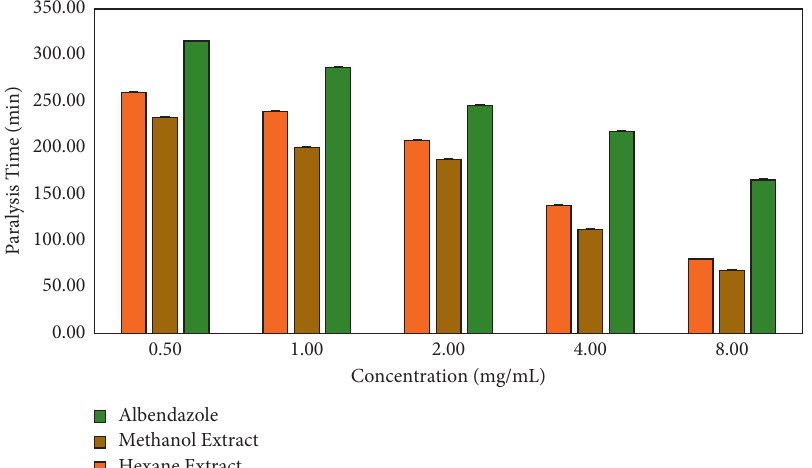
Figure 2: Anthelmintic activity of the extracts of V. camporum and albendazole. Each time represents mean ± SEM ( N � 3); ∗∗∗ P < 0 . 001 compared to the albendazole treatment using one-way ANOVA.